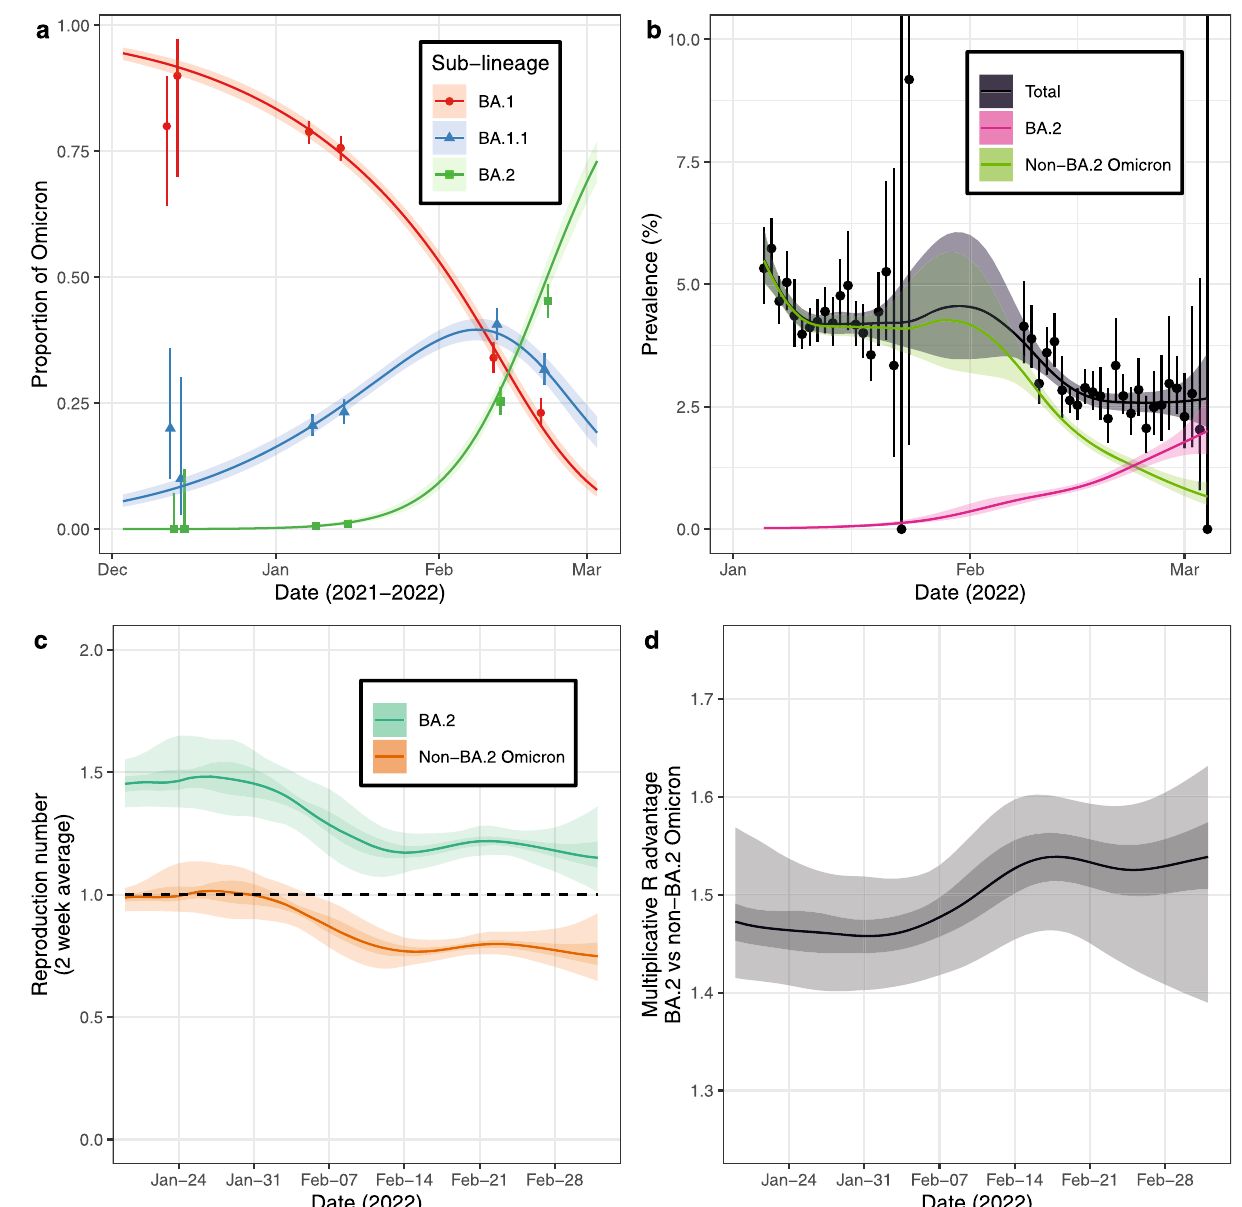
Fig. 3 | Dynamics of Omicron sub-lineages. a Modelled proportion of Omicron lineages that are BA.1, BA.1.1 and BA.2, estimated for using a Bayesian multinomial logistic regression model. Estimates of proportion are shown with a central esti- mate (solid line) and 95% (shaded region) credible intervals. Point estimates of mean proportion (points) are shown with 95% con fi dence intervals (error bars) for each halfround of REACT-1 with x-axisvalue set by the median date(jittered for all lineagesforvisualisation). b ModelledprevalenceofBA.2andnon-BA.2Omicronin England estimated using a mixed-effects Bayesian P-spline model. Estimates of prevalence are shown with a central estimate (solid line) and 95% (shaded region) credibleintervals.Dailyweightedestimatesofmeanprevalence(points)areshown